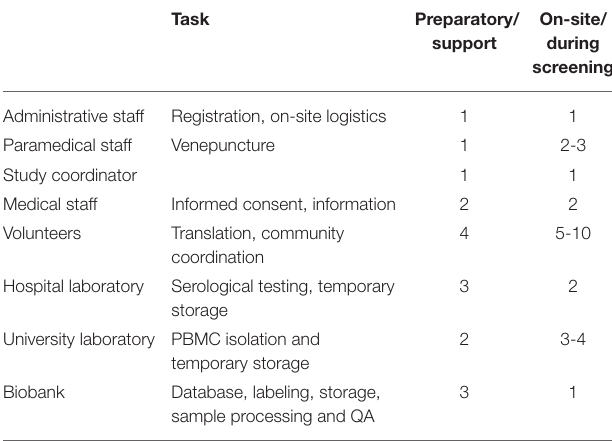
TABLE 4 | Staff and tasks involved in the preparation and execution of biobanking during on-site screenings.